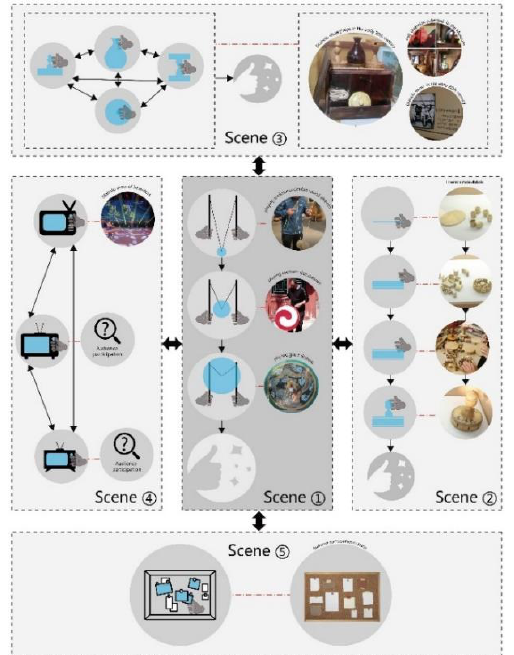
Figure 5 . Reconstruction of Interactive Events. Source: